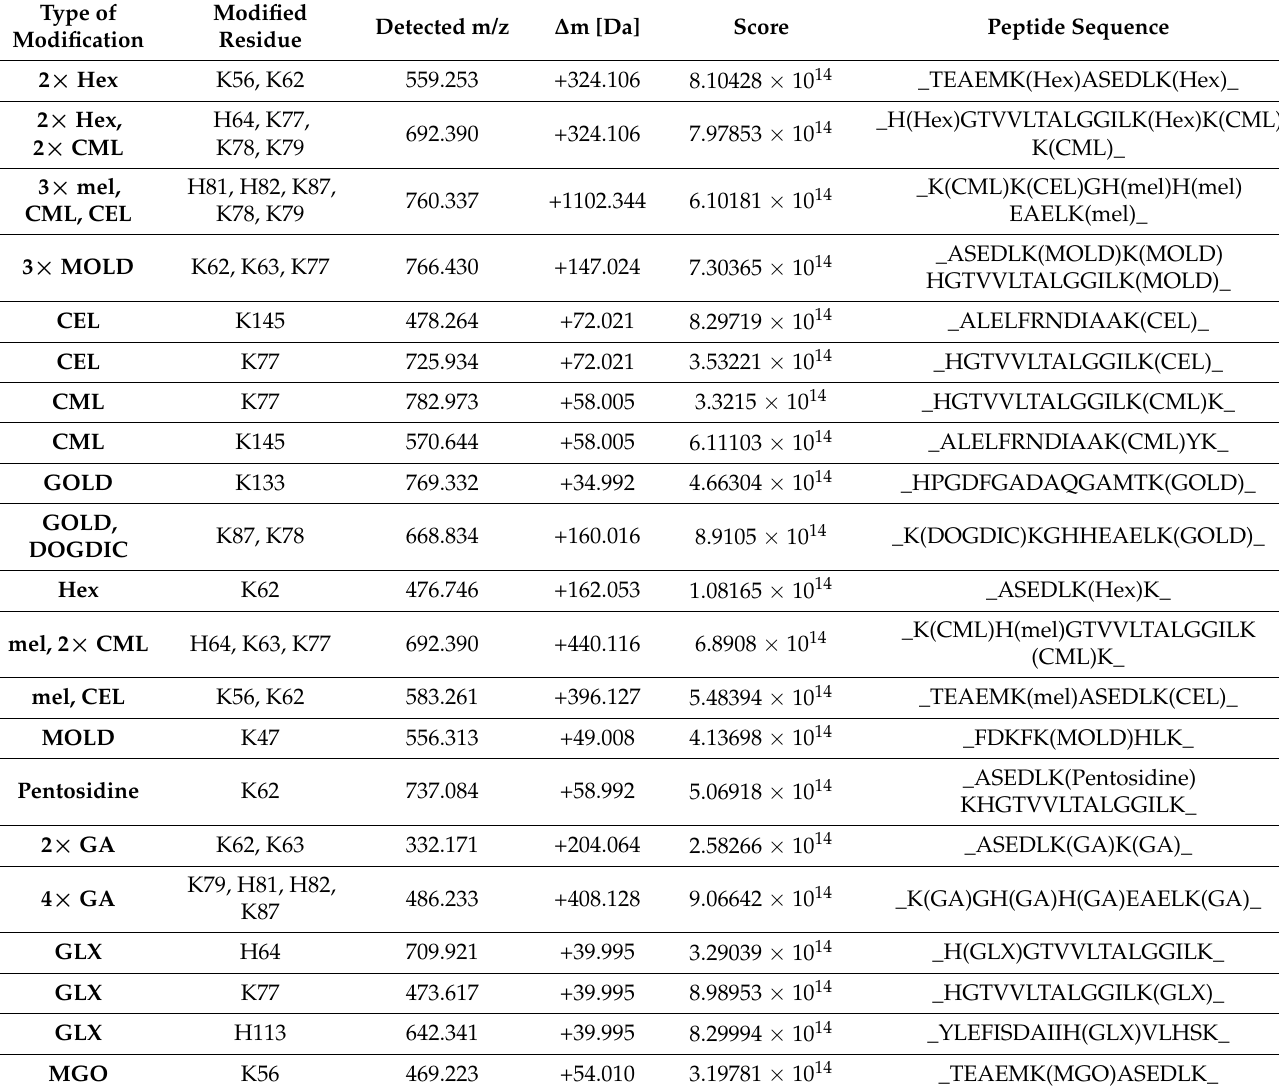
Table 3. Glycation adducts identified in MB-mel formed in aqueous conventional glycation